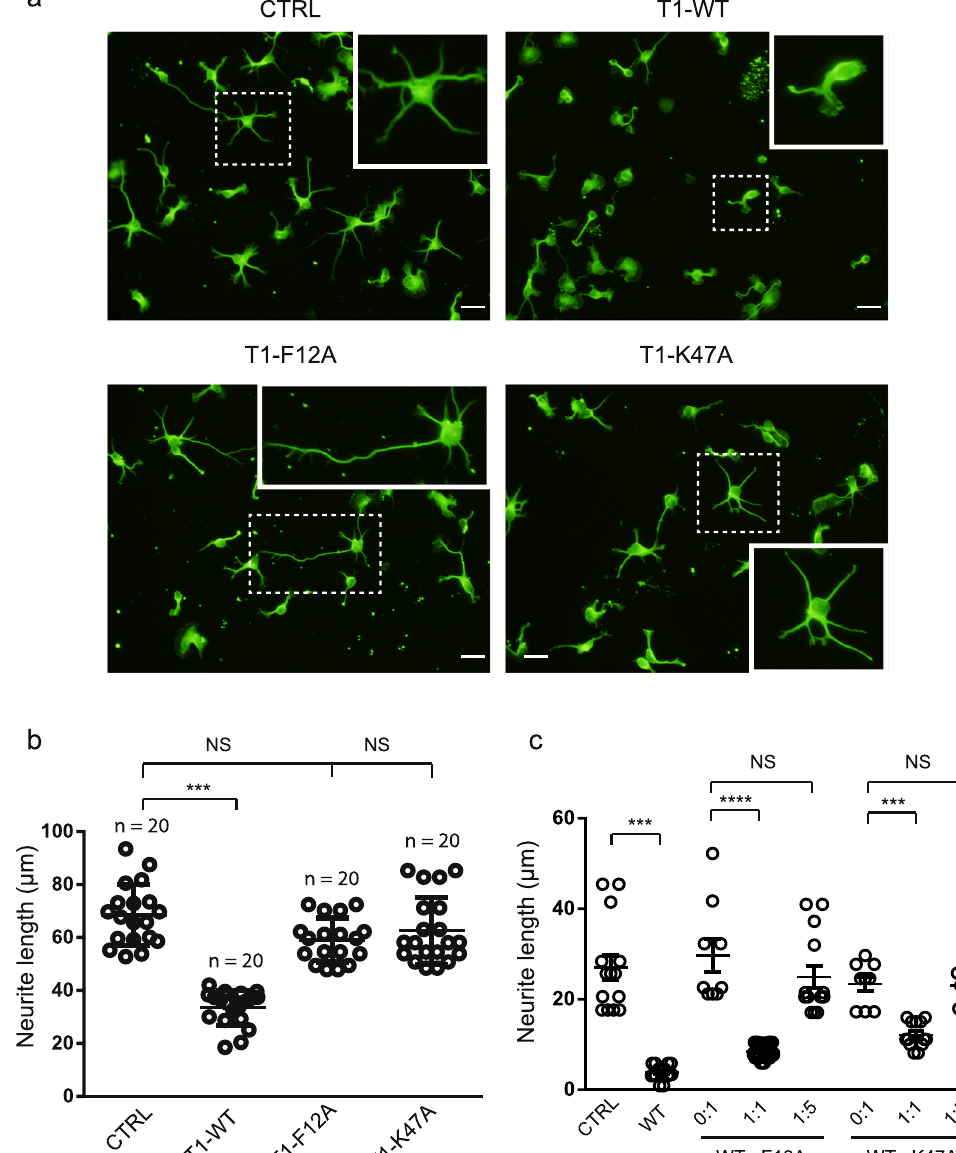
Figure 5. Effect of TIMP-1 mutants on neurite outgrowth. ( a ) Immunofluorescence of cortical neurons from mouse embryos cultured for 24 h on poly-L-lysine-coated coverslips and then treated for 30 min with PBS (CTRL) or 5 nM T1-WT, T1-F12A and T1K47A. Cells were labelled with anti- β III-tubulin monoclonal antibody and observed by fluorescent microscopy. The images are representative of more than three distinct experiments. Scale bar: 10 µ m. ( b ) Quantification of neurite mean length per cell performed using the ImageJ plugin NeuronJ. For each group, at least 20 randomly selected fields were analysed in three independent experiments (n = 20). The data are representative of at least three independent experiments with at least five mice embryos. Error bars indicate mean ± SD, *** indicates P-value < 0.00 and NS indicates a value that is not statistically significant. ( c ) Neurite mean length of cortical neurons from mouse embryos cultured for 24 h on poly-L-lysine-coated coverslips and then treated for 30 min with PBS (CTRL) or T1-WT or co-treated with different T1-WT/T1-F12A or T1-WT/T1-K47A ratios (0:1, 1:1 and 1:5). Cells were labelled with anti- β III-tubulin monoclonal antibody, observed by fluorescent microscopy and analysed with the ImageJ plugin NeuronJ Quantification. For each group, at least 10 randomly selected fields were analysed (n = 10). The data are representative of at least three independent experiments with at least five mice embryos. Error bars indicate mean ± SEM, *** indicates P-value < 0.001 and NS indicates a value that is not statistically